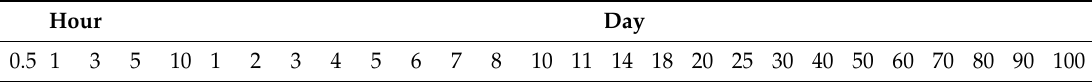
Figure 2. Test setup. Table 2. Deformation measurement time.